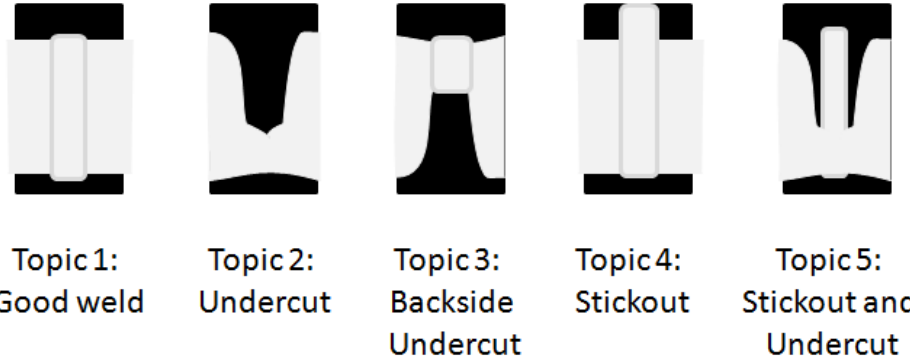
Figure 3. Laser pipe welding conformance issues relevant to American National Standard Institute / American Welding Society (ANSI / AWS) standards. These are cluster definitions one might want so that topics align with human used words and concepts. These images could appear in a welding training manual describing defect types.